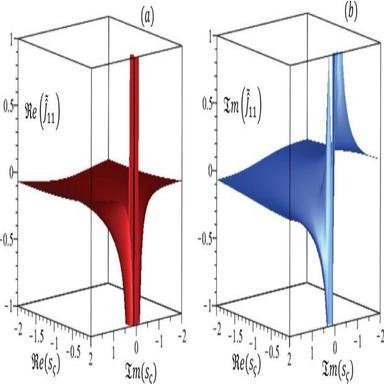
(a) Dimensionless real part component Re(˜ˆJ11 ) vs. Re(sς ) and Im(sς ). (b) Dimensionless imaginary part component Im(˜ˆJ11 ) vs. Re(sς ) and Im(sς ), with rρ = 10, rE = 10, τ i ς = 10, i = 1, 2, ν˜1 = ν˜2 = 0.2, η = 1 and γ = 1.